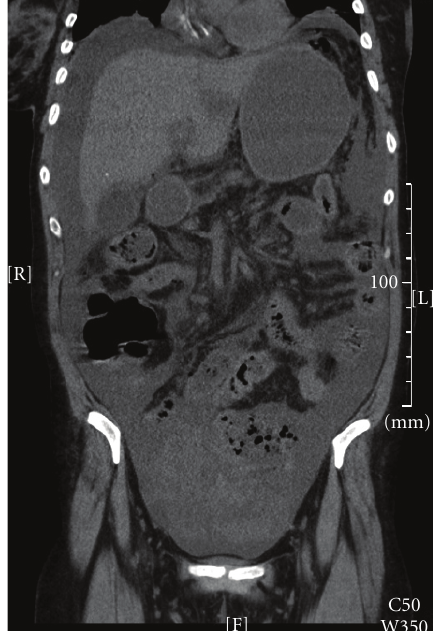
Figure 1: CT showing mass-like cystic structure in pelvis with air